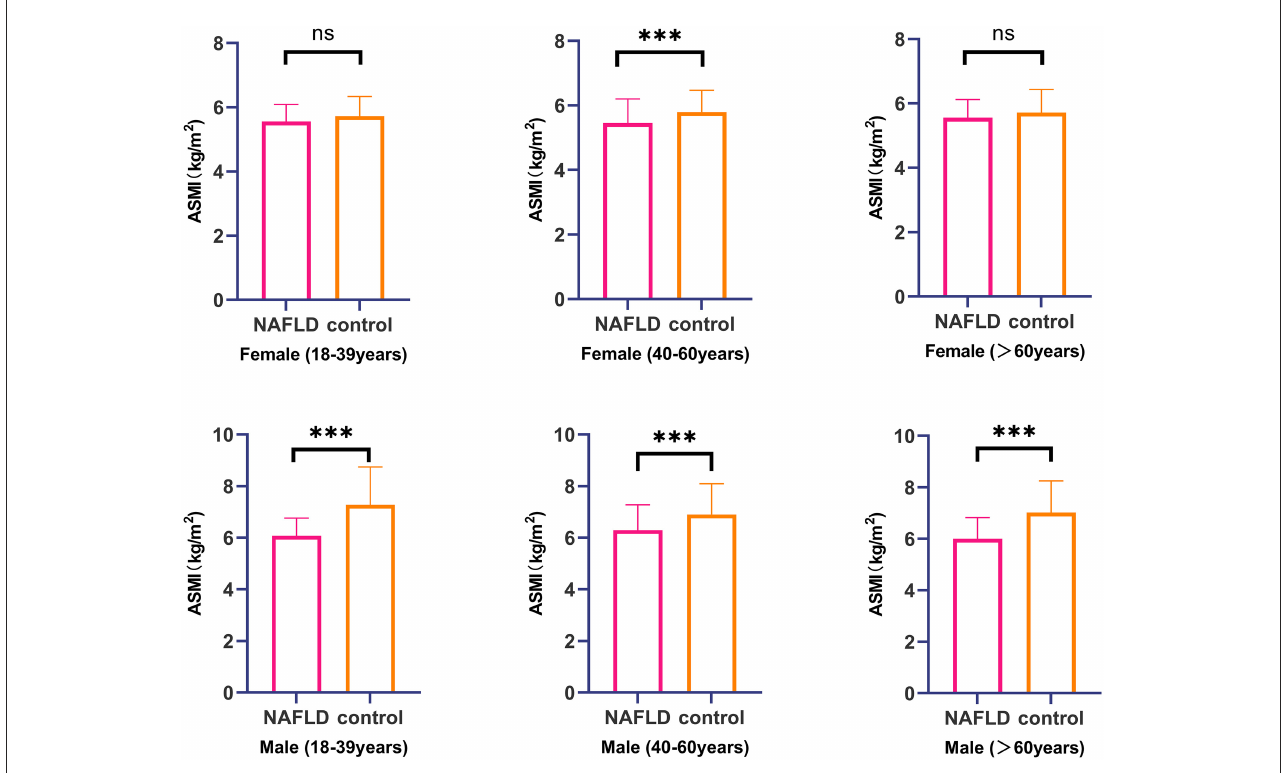
FIGURE1 Comparison of ASMI value between NAFLD group and control group stratified by gender and age range. ***, P <0.001; NS, no